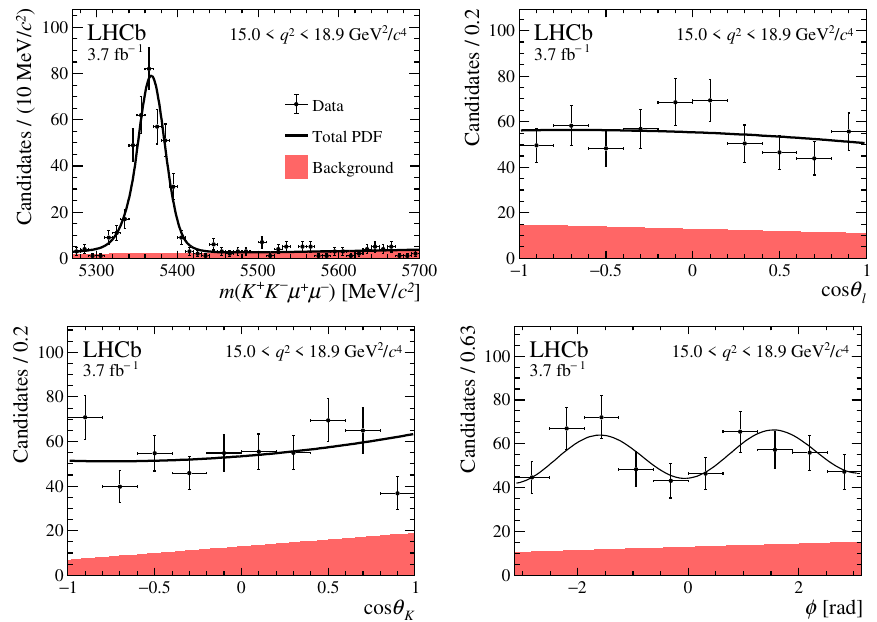
Figure 32 . Mass and angular distributions of B 0 15 . 0 < q 2 < 18 . 9 GeV 2 /c 4 for data taken in 2017–2018. The data are overlaid with the projec- tions of the fitted